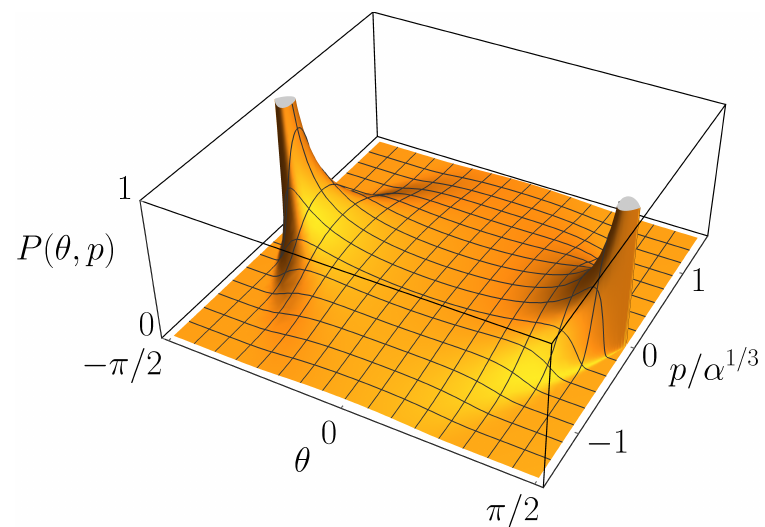
Figure 4: Joint angle and momentum probability distribution function of the NFT, P ( θ , p ) in the limit ω = 0, as follows from Eq.